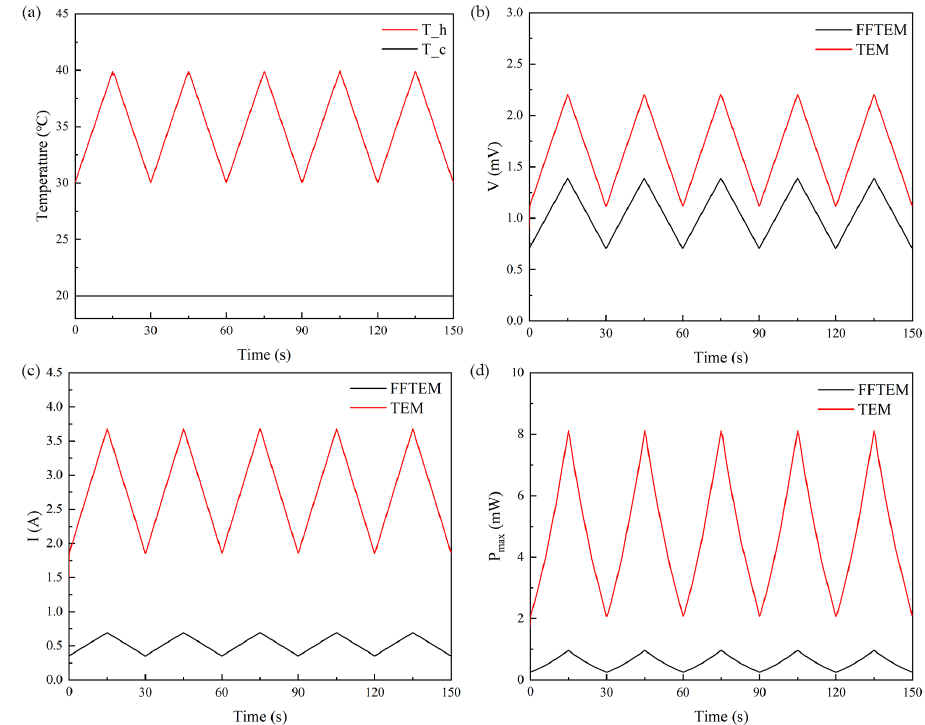
Figure 10. ( a ) Boundary temperature, ( b ) output voltage, ( c ) working current, and ( d ) maximum output power for the FFTEM and TTEM models as a function of